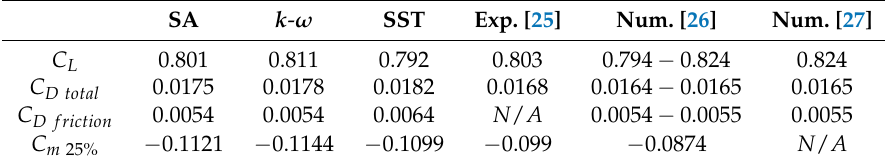
Table 1. Lift, drag and moment coefficients in